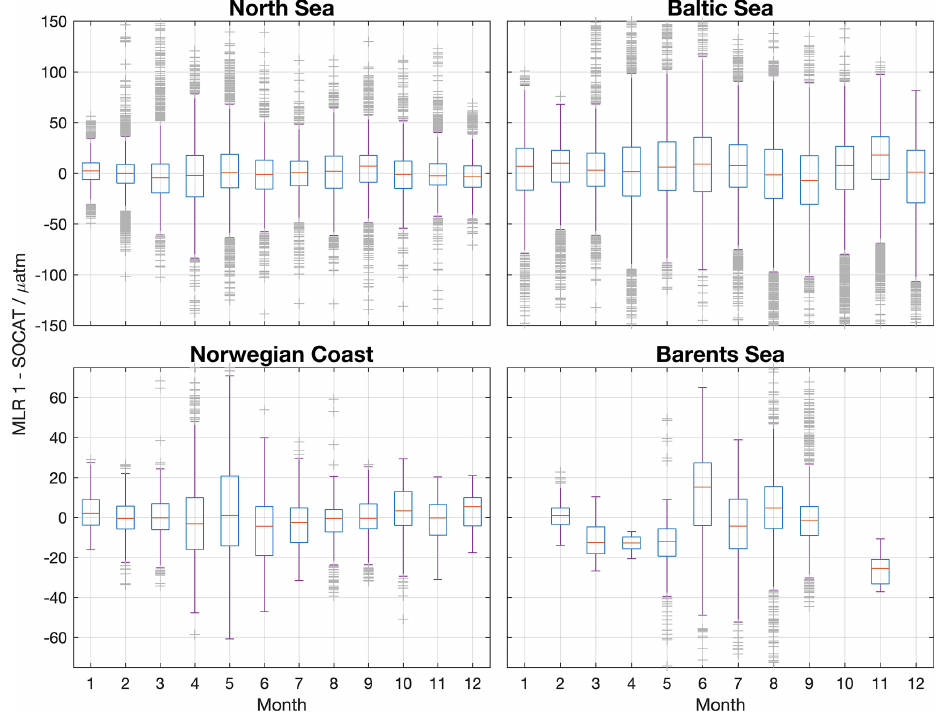
Figure 6. Boxplots showing the median deviation of MLR 1 from the gridded SOCAT 5 data for each region (red line). The boxes show the upper and lower 75th percentiles. Ninety-nine percent of the data lie within the range of the purple whiskers. Extremes are shown as gray